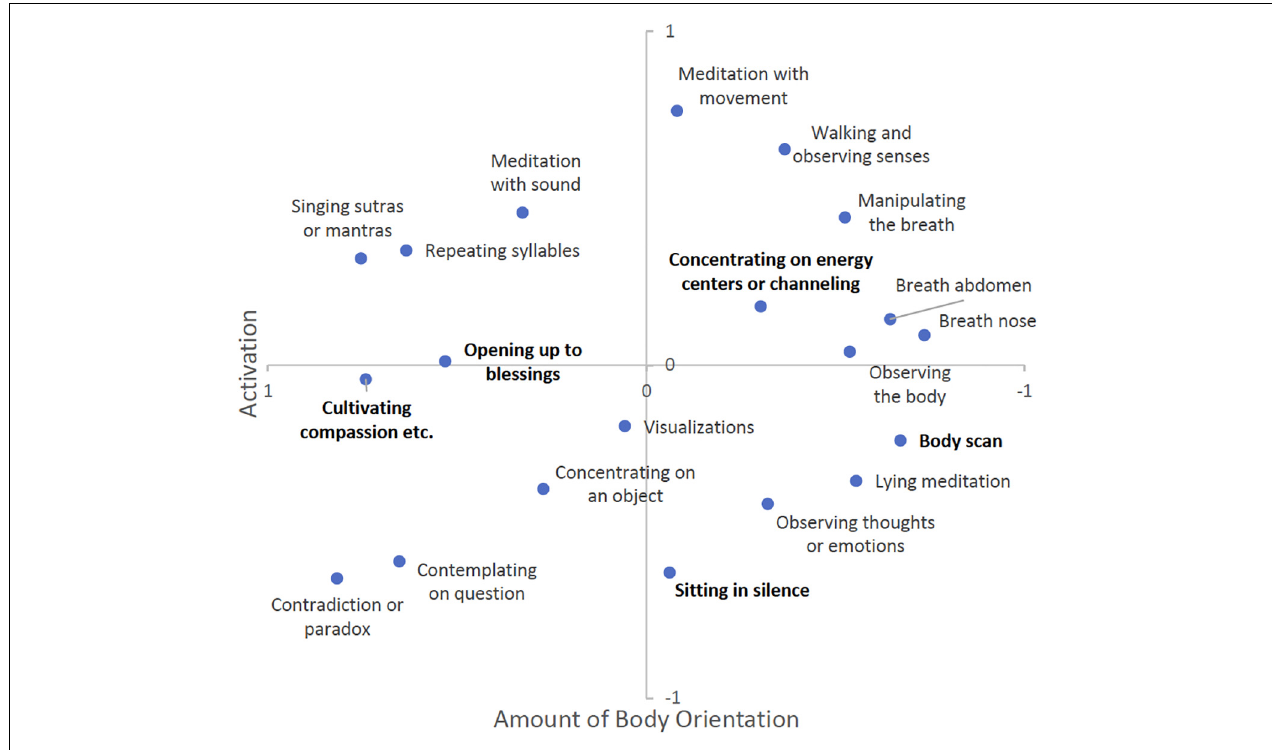
FIGURE 4 | Multidimensional scaling (MDS) solution for Hindu meditators ( n =